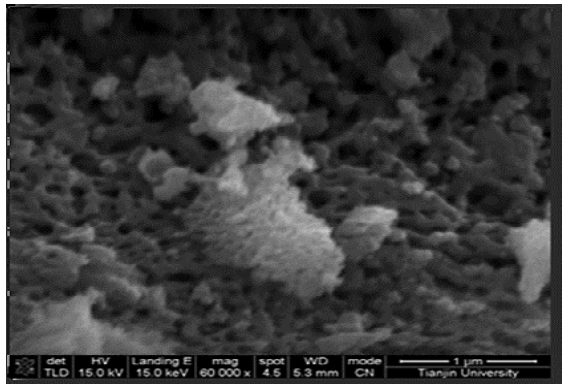
Figure 8. EM micrographs of LaFeO ₃ nanocrystalline particles calcined at 450